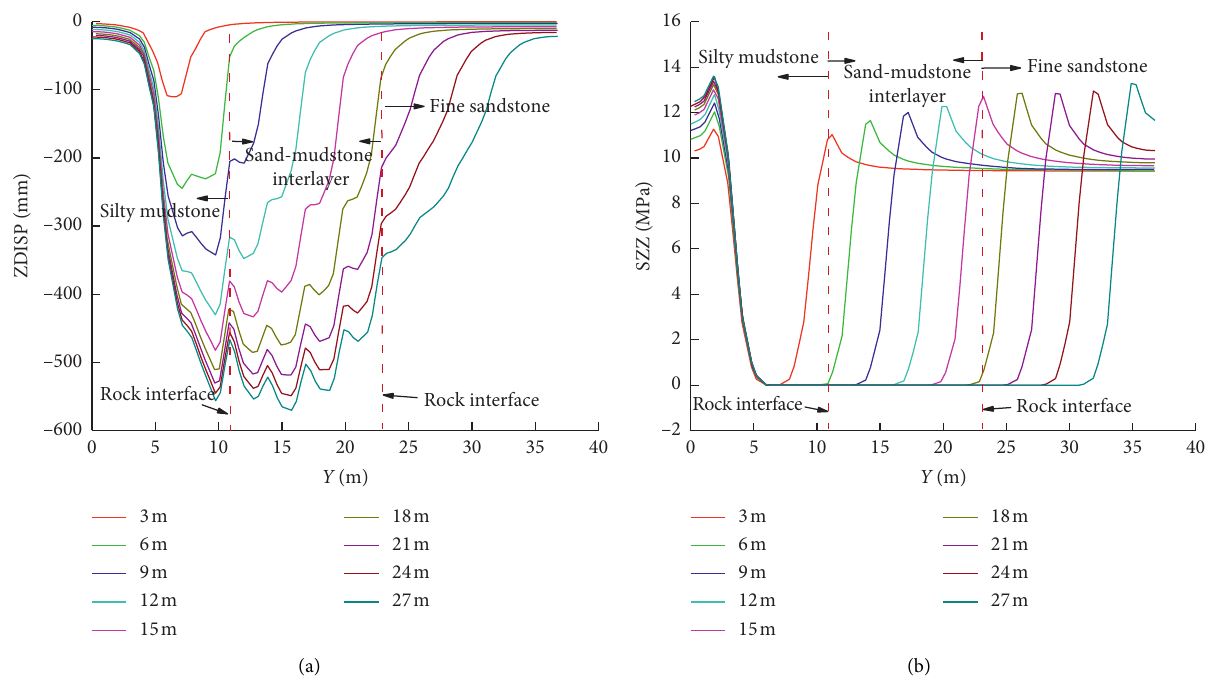
Figure 11: Movement law of roof strata and the evolution law of abutment stress in front of and behind the roadway. (a) Movement law of roof strata. (b) Evolution law of abutment